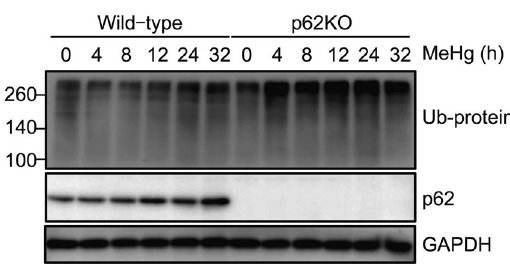
Figure 4. p62 deficiency increases the levels of ubiquitinated proteins after methylmercury (MeHg) treatment. Wild-type and p62-defecient mouse embryonic fibroblasts were seeded in 6-cm dishes for treatments. After treatment with 1 µ M MeHg for 0–24 h, whole cell lysates were immunoblotted with anti-ubiquitin and p62 antibodies. GAPDH was used as the loading